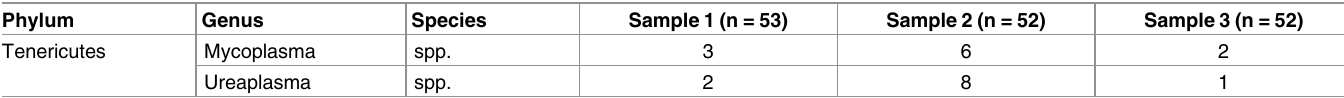
Table 3. Number of uterine samples that cultured positive for mycoplasma and ureaplasma collected on the day of calving (sample 1), the day of follicle aspiration ± 1 (sample 2), and at 35 ± 1 days postpartum (sample 3). Phylum